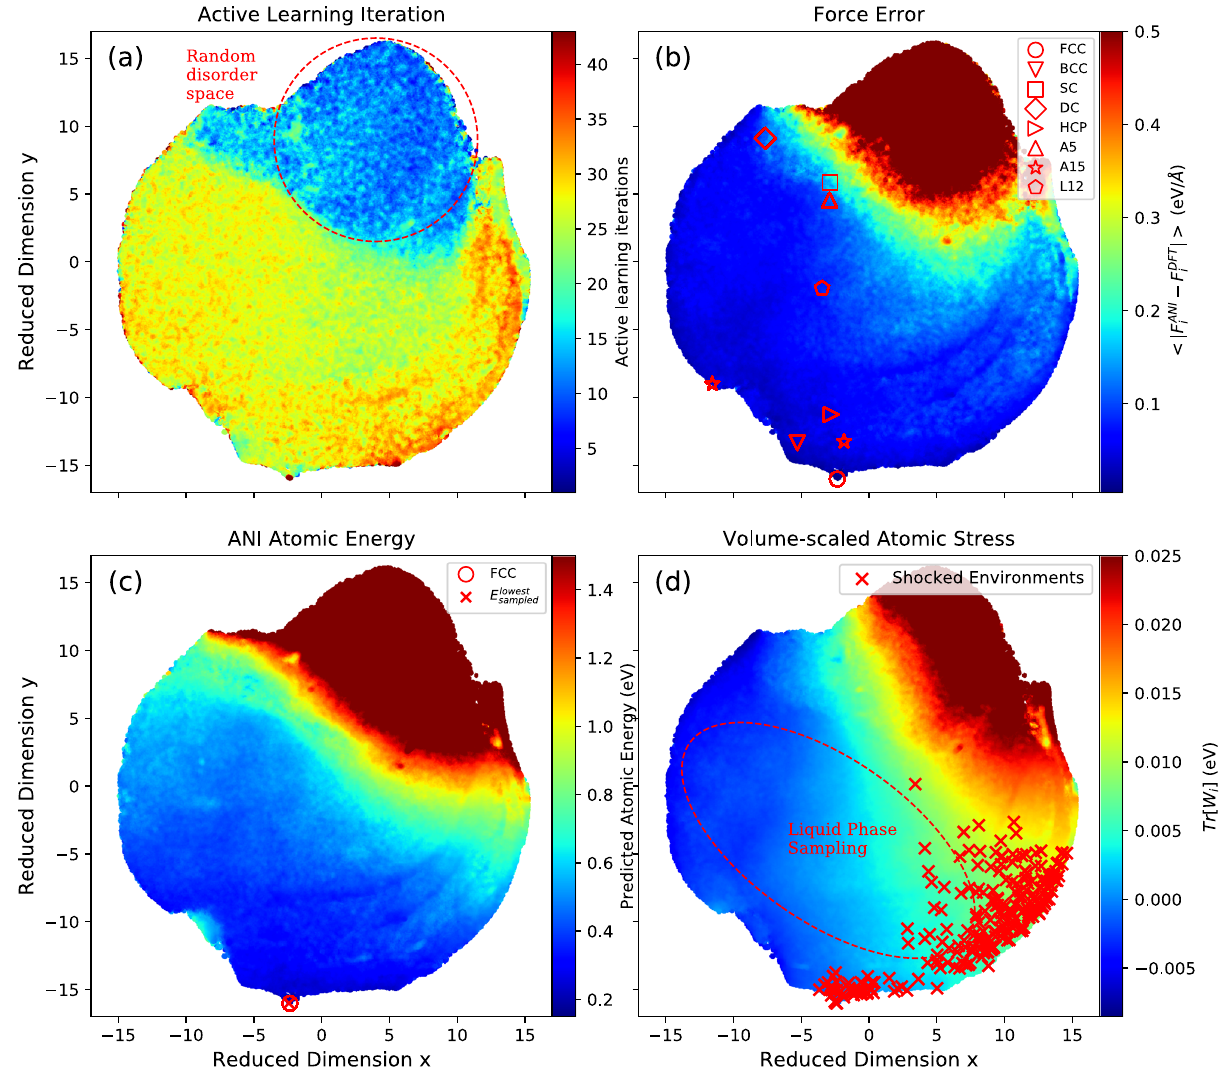
Fig. 8 Visualization of the atomic con fi gurations sampled by active learning. We used the t-distributed stochastic neighbor embedding (t-SNE) method to map local atomic environments into two dimensions. Radial neighbor regression (RNR) is used to color the average property within a radius of a given point in the 2D embedding space. a Active learning iteration at which a sample was taken; disordered space is circled. b Force error; eight crystal structures are marked. c ANI predicted atomic energy; FCC is observed to be the lowest energy con fi guration in the embedding space. d Volume-scaled atomic stress; shocked environments are marked and liquid environments